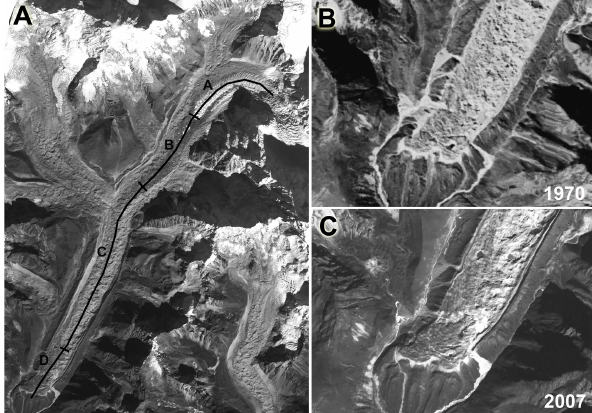
Fig. 5. (A) : Khumbu Glacier based on the 2007 Cartosat-1 image including the profile and the different sections of surface lowering (see Fig. 6A). (B, C) : Terminus of Khumbu Glacier based on the 1970 Corona KH-4B and on the 2007 Cartosat-1 image.